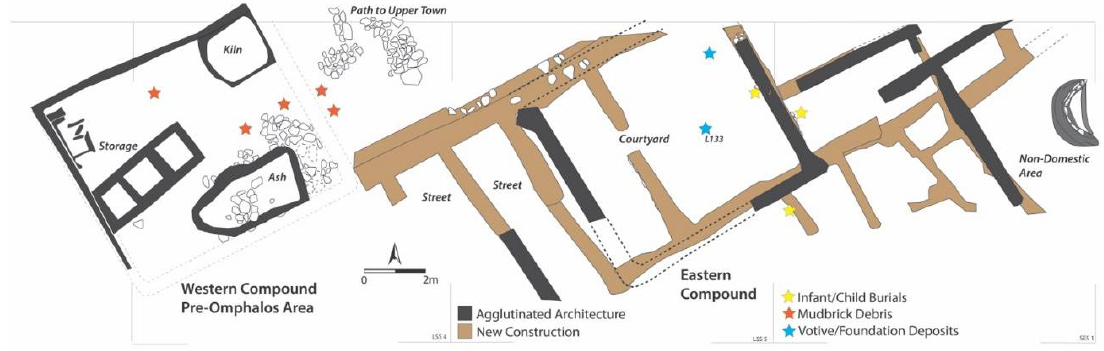
Figure 7. Plan of the post-Agglutinated phase and preparation for the upcoming Burnt House and Omphalos Building phase, showing locations of burials and votive/foundation deposits.